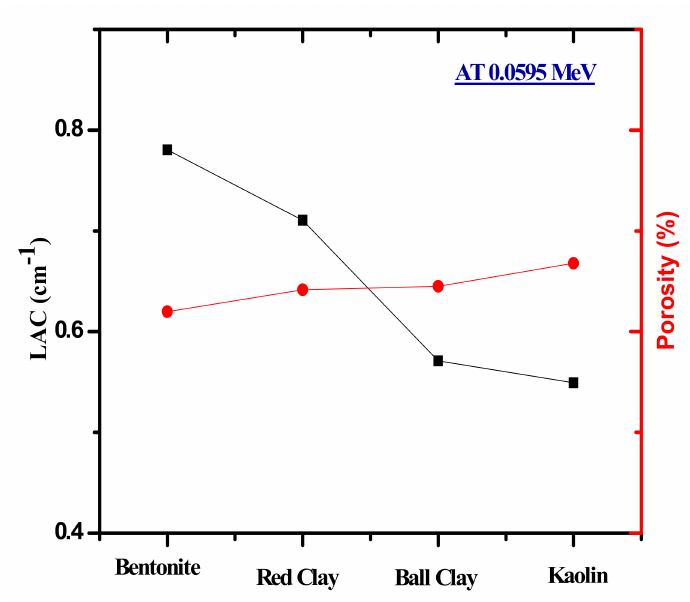
Figure 6. The porosity as a function of clay samples as well as the LAC values for the four investigated clay at 0.060 MeV.